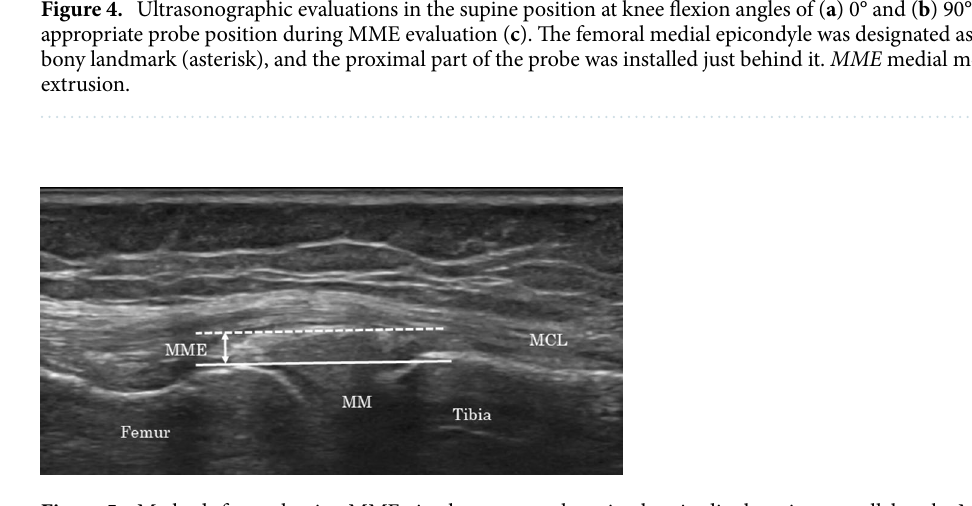
Figure 5. Methods for evaluating MME via ultrasonography using longitudinal sections parallel to the MCL. MCL medial collateral ligament, MME medial meniscal extrusion, MM medial